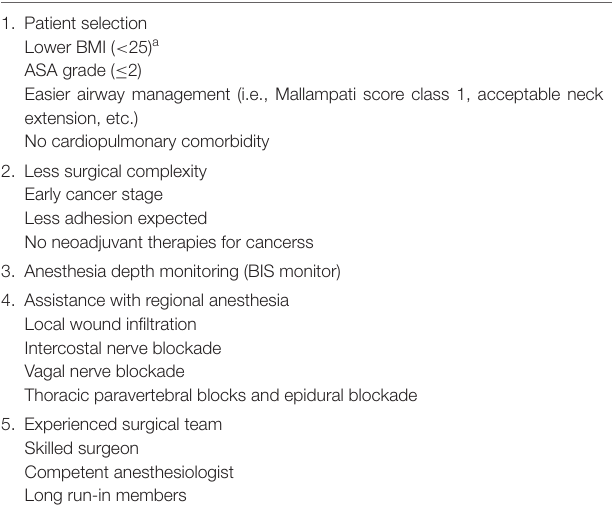
TABLE 2 | Considerations for avoiding conversions during non-intubated thoracoscopic